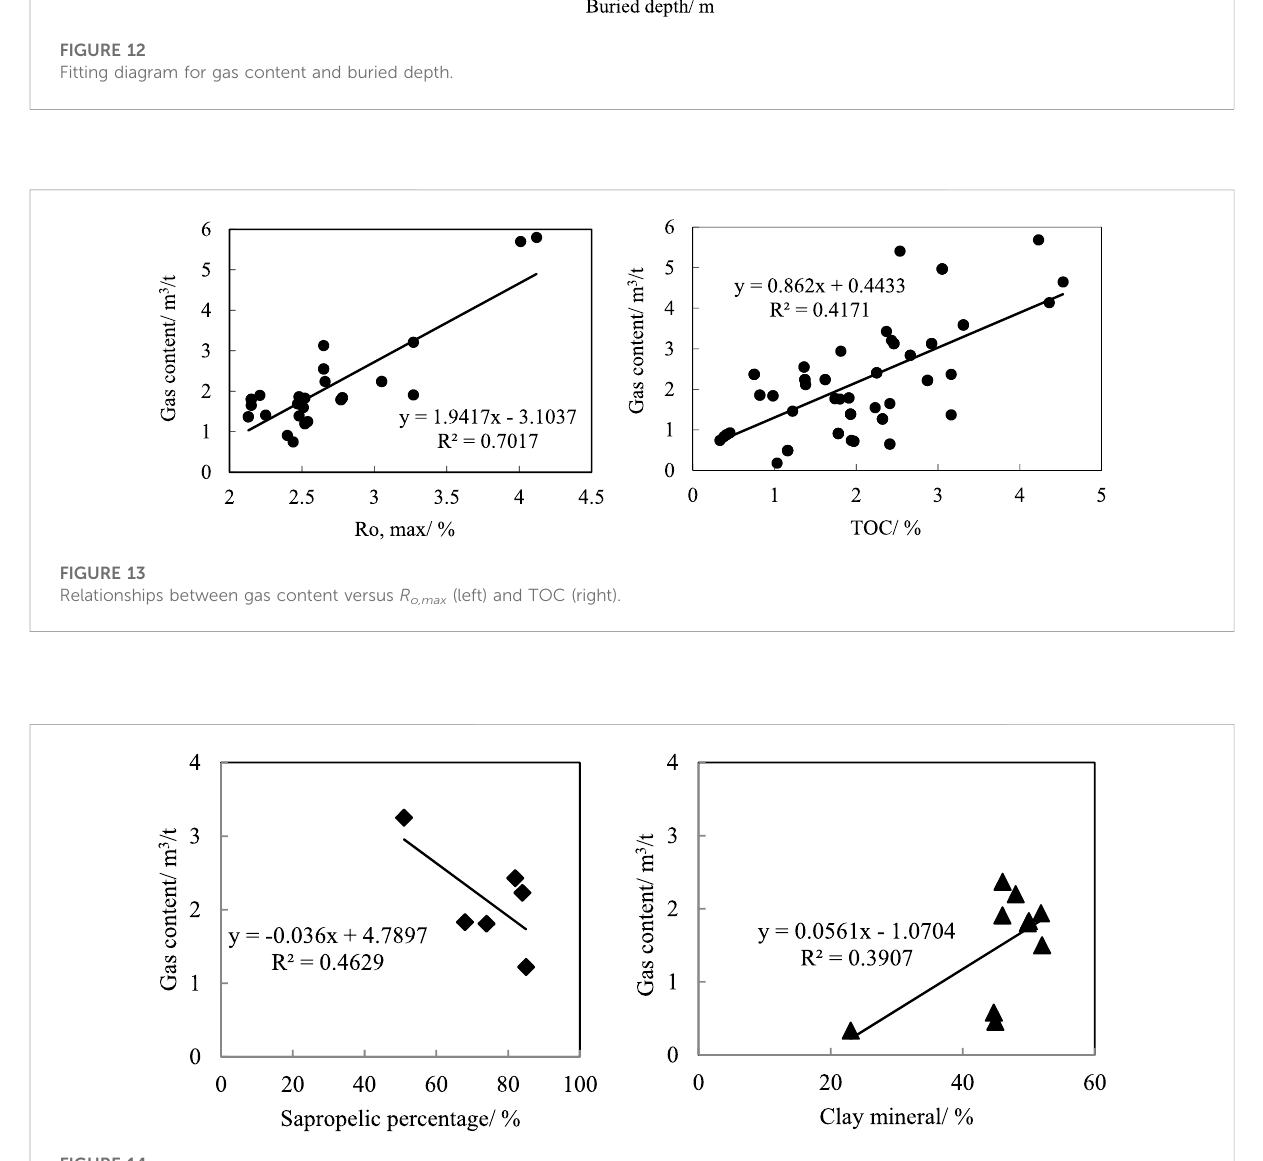
FIGURE 14 Relationships between gas content versus sapropelic percentage (left) and clay mineral (right).